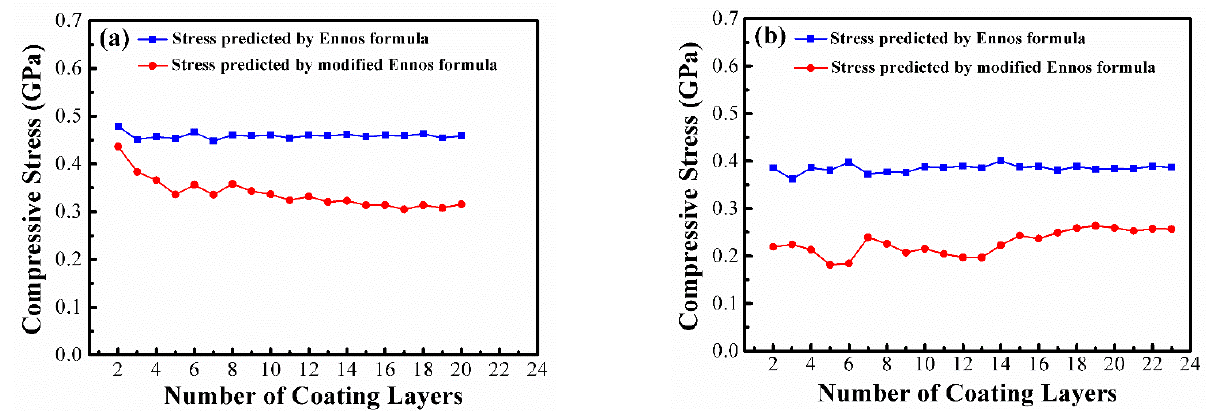
Figure 5. Internal stress prediction and comparison of ( a ) 20-layer; ( b ) 23-layer MIR-BPFs. Table 1. Comparison of the predicted and measured stresses in 20-layer and 23-layer MIR-BPFs. BPF